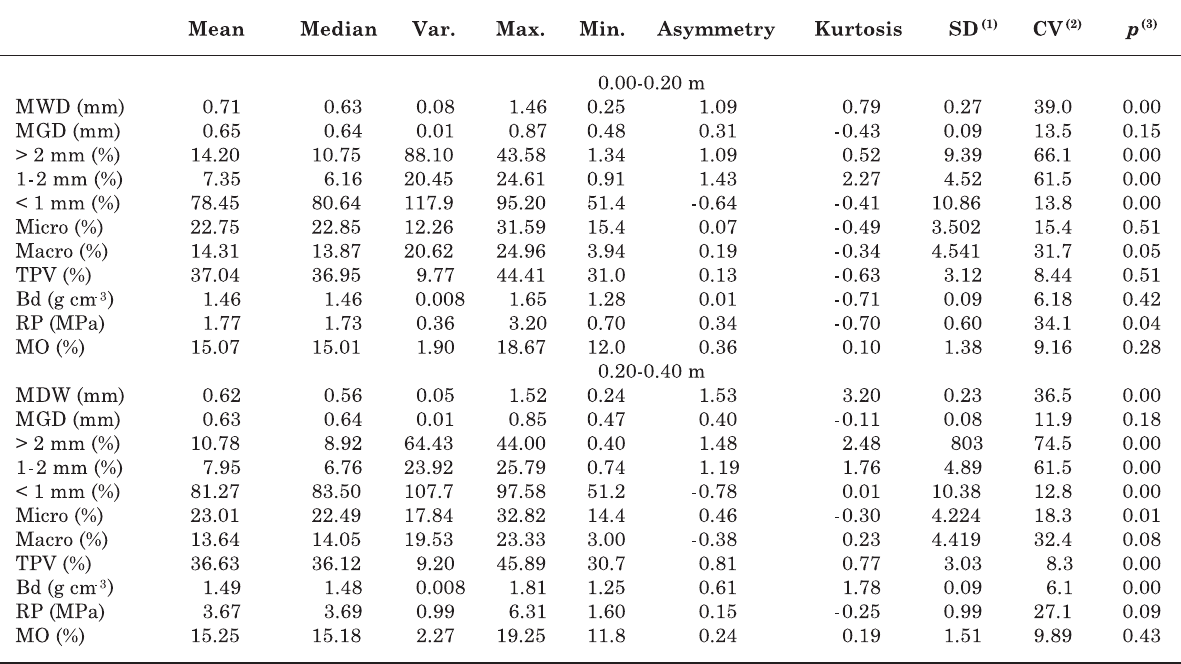
Table 2. Descriptive statistics of attributes of the convex area: mean weighted diameter (MWD), mean geometric diameter (MGD), aggregates > 2 mm (> 2 mm), aggregates 1–2 mm (1–2 mm) and aggregates < 1 mm (< 1 mm), micropores (micro), macropores (macro), total pore volume (TPV), bulk density